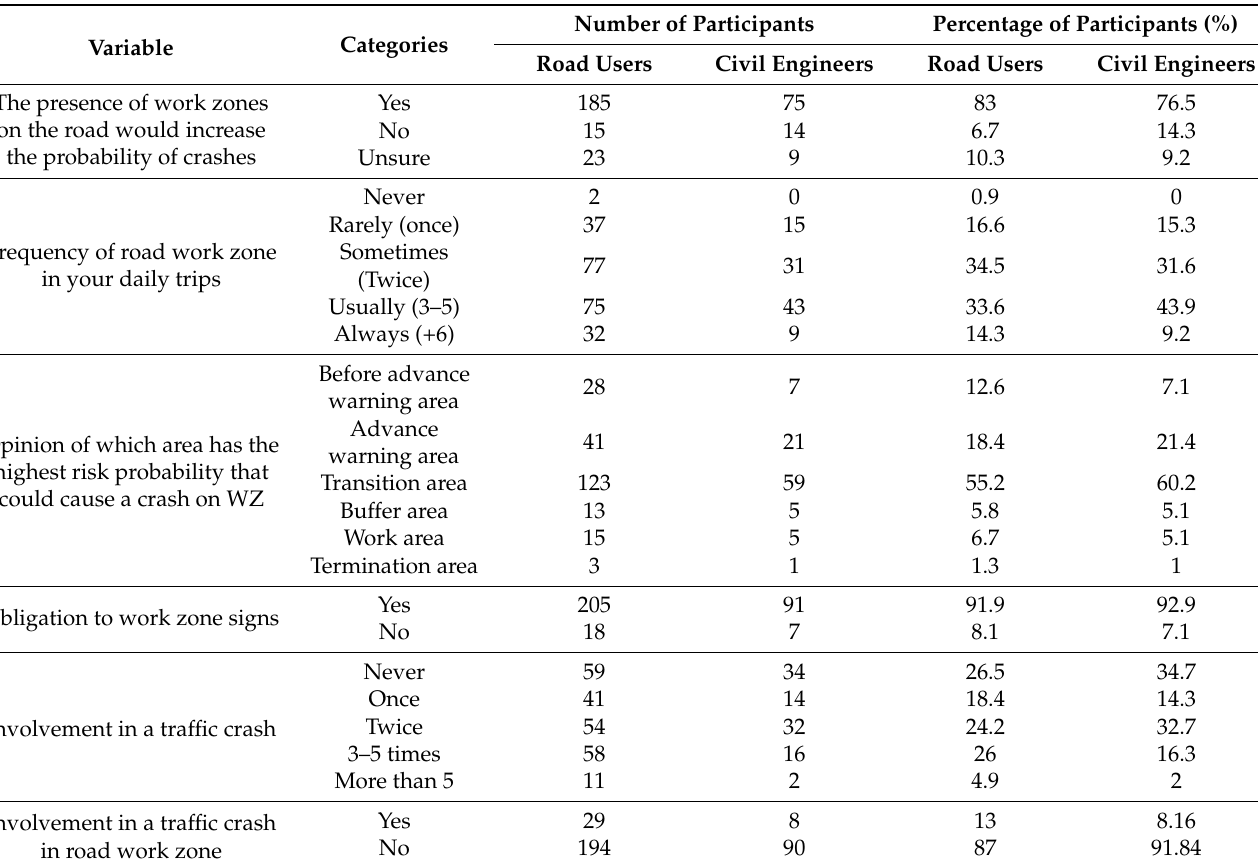
Table 2. Responses of the crashes’ causes part (six general